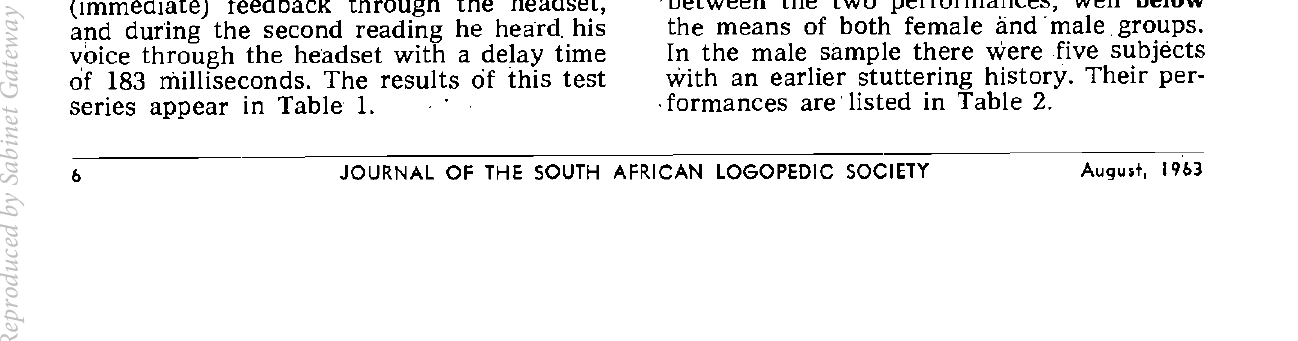
Fig. 2 Modified tape recorder for